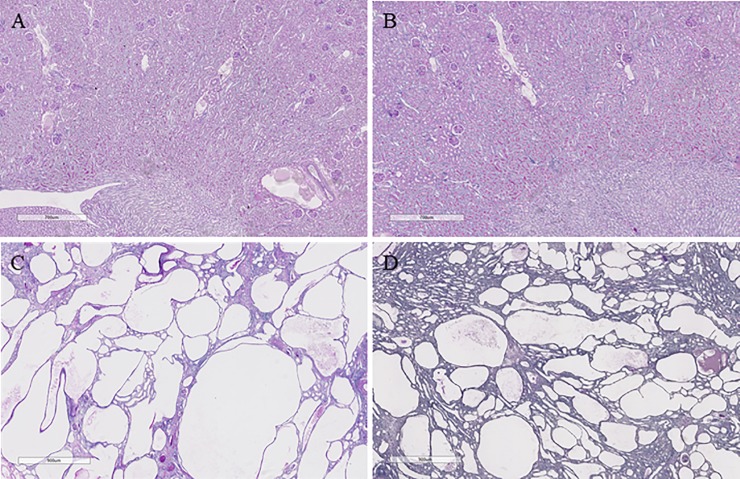
Representative photomicrographs of periodic acid Schiff-stained sections of kidney showing effects on cyst growth at week 10 in Lewis+NWI (A), Lewis+HWI (B), LPK+NWI (C) and LPK+HWI (D). There was no change in renal structure in the Lewis rats with HWI, whereas in LPK rats there was a marked attenuation in the renal cystic tubular dilation (D vs. C).